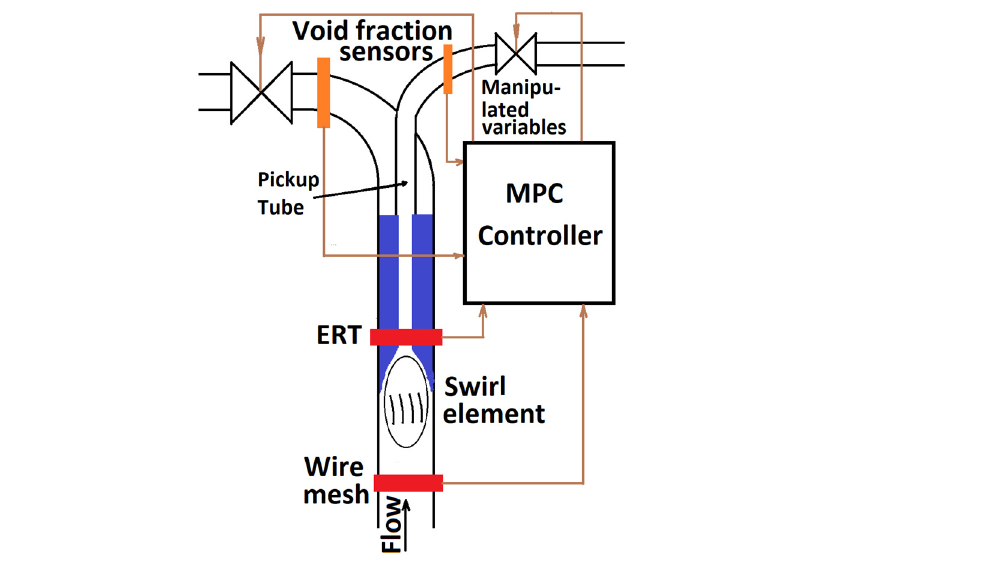
Figure 4 . Schematic sketch of the swirled separator process. Figure 4. Schematic sketch of the swirled separator